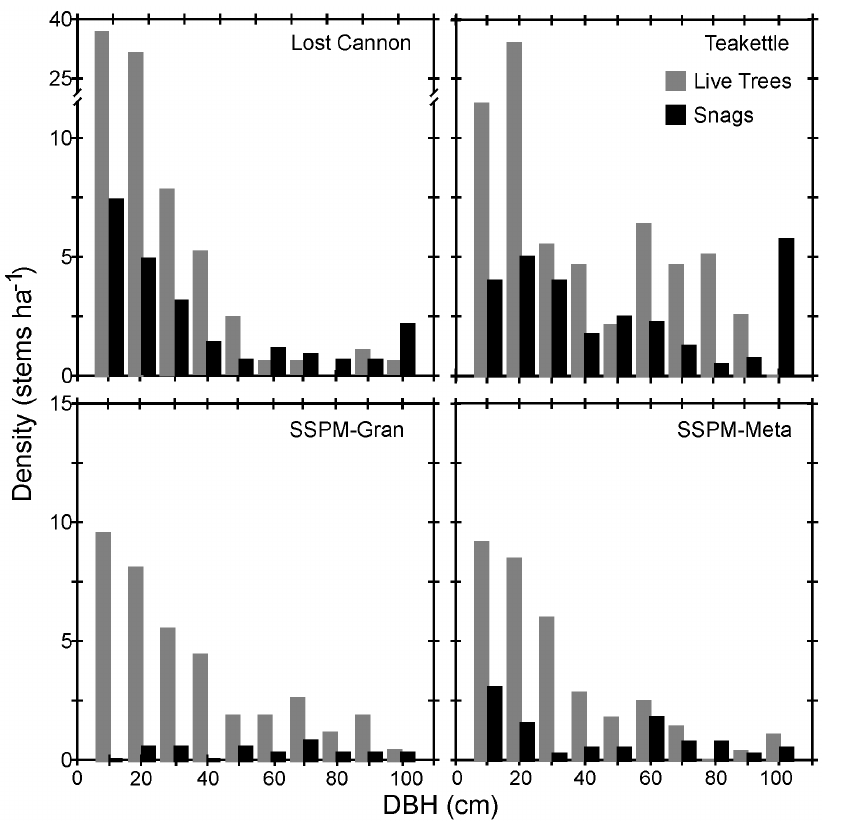
Figure 5. Tree diameter distributions (10 cm size classes) by density for snags and live single (i.e., non-patch) trees in 4-ha stem mapped plots.